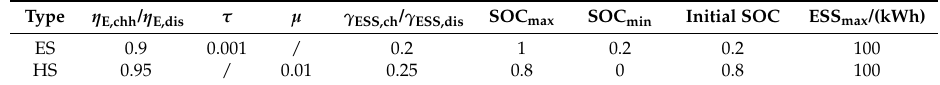
Table 4. Pollutant emission coefficients and penalty prices